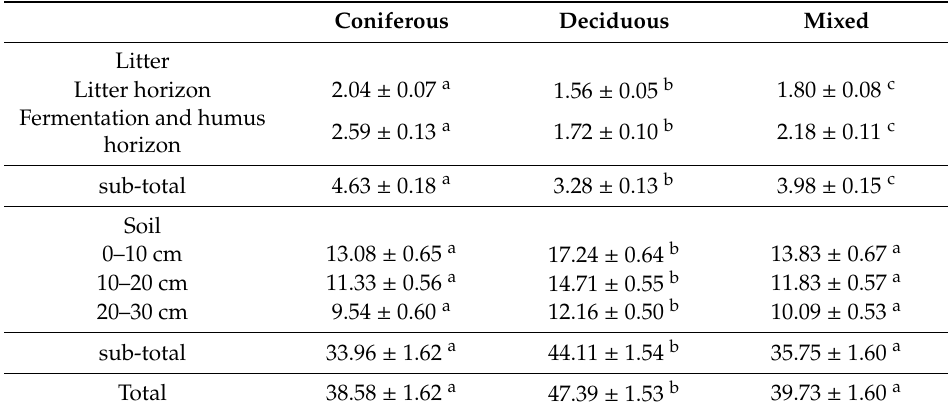
Table 3. Litter and soil at 0–30 cm carbon stock in South Korea (unit: t C ha − 1 , mean ± standard